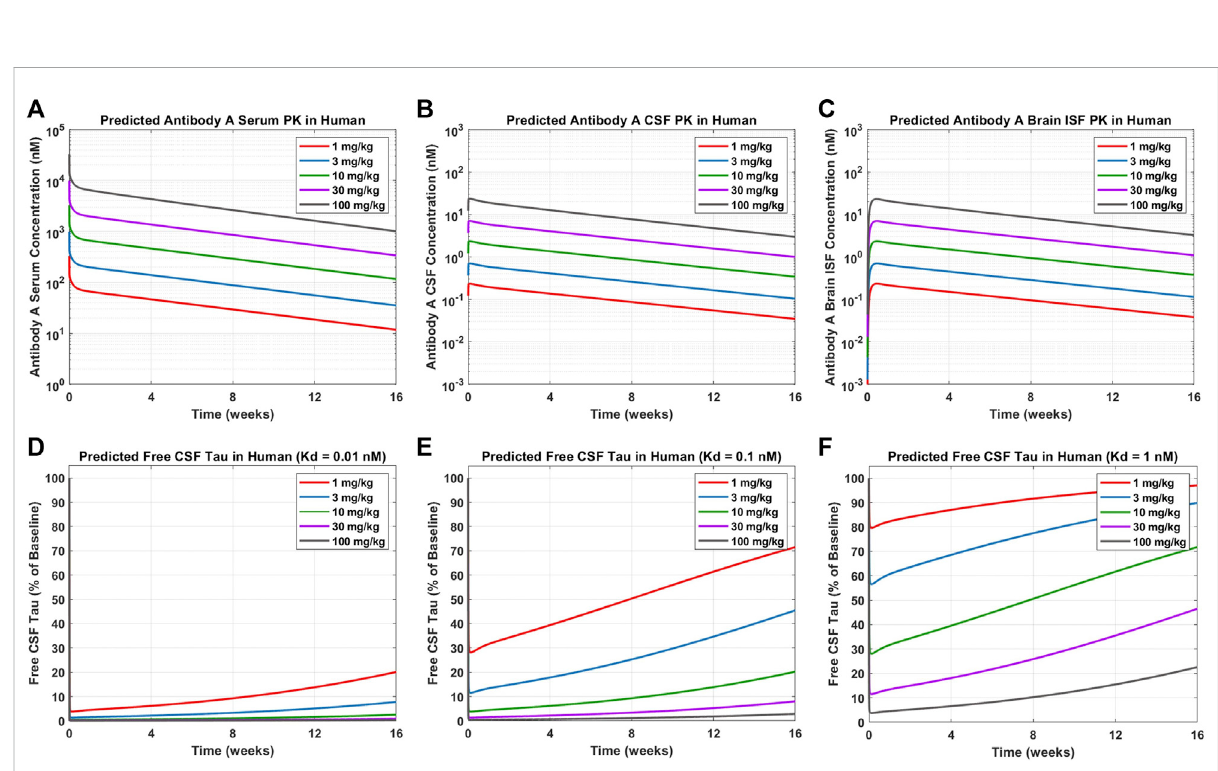
Model predictions for Antibody A PK and CSF ptau dynamics in humans. Antibody A concentrations in human (A) serum, (B) CSF, and (C) brain ISFatasingleIVdoseof1,3,10,30,100 mg/kg.ThechangeinfreeCSFtauisshownforthreedifferentscenariosofdifferentantibodyaf fi nitiestotau: (D) 0.01 nM, (E) 0.1 nM, and (F) 1 nM. Antibody and antibody-target complex elimination half-life was assumed to be approximately 40